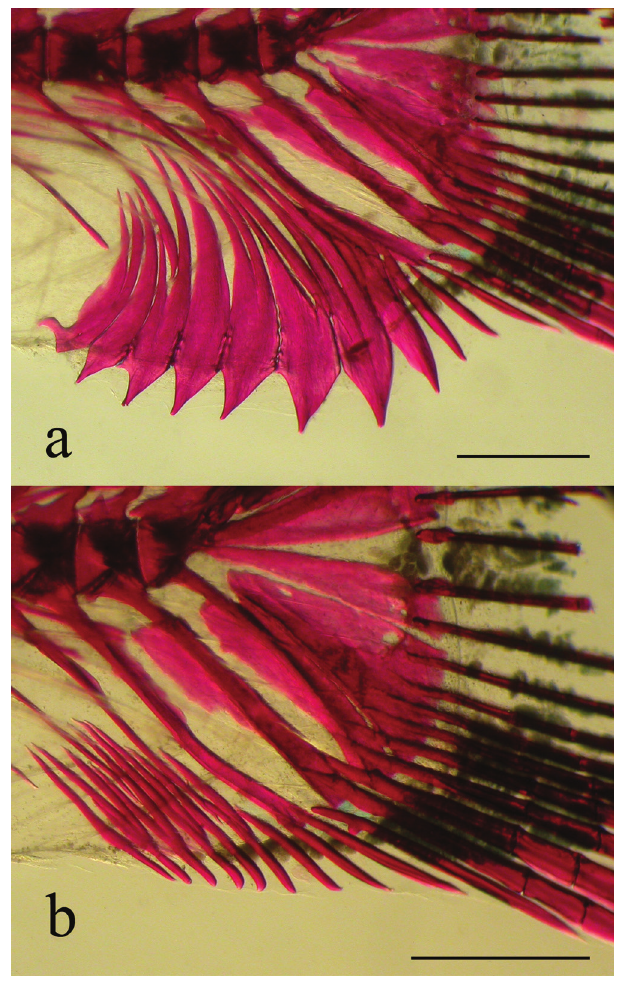
Fig. 2. Ventral procurrent caudal-fin rays of Serrapinnus potiguar : ( a ) paratype, male, UFRGS 9216, 27.4 mm SL; ( b ) paratype, female, UFRGS 9216, 27.6 mm SL. Lateral view, anterior to the left. Scale bars = 1